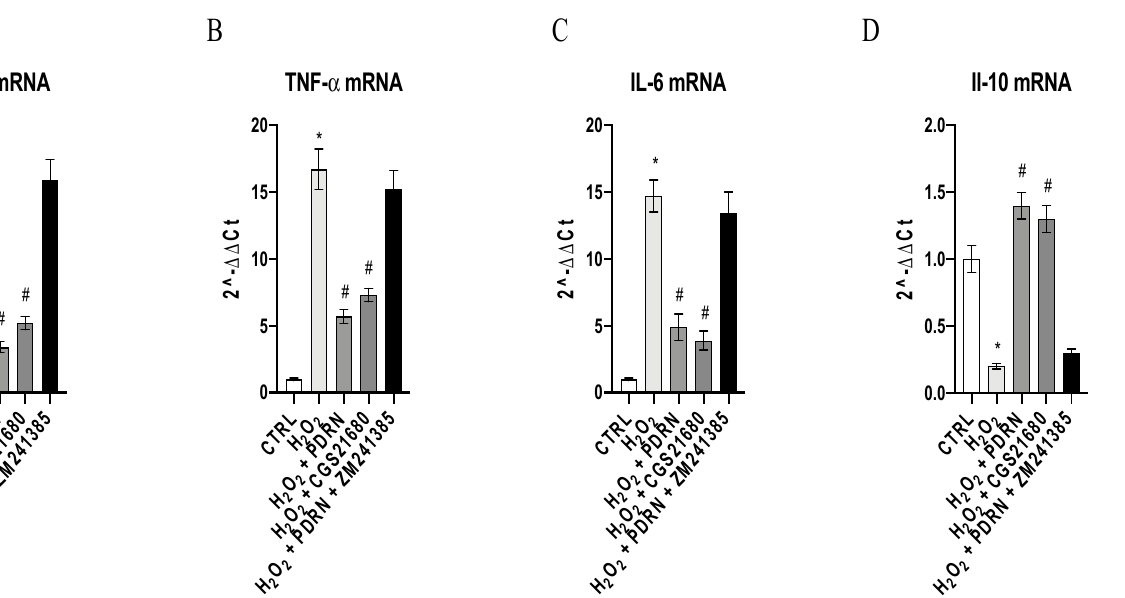
Figure 3. The graphs represent the qPCR results of Il-1 β ( A ), TNF- α ( B ), Il-6 ( C ) and Il-10 ( D ) gene expression in IHCE cells. The values are expressed as the means and SD. * p < 0.0001 vs. CTRL; # p < 0.0001 vs. H 2 O 2 .